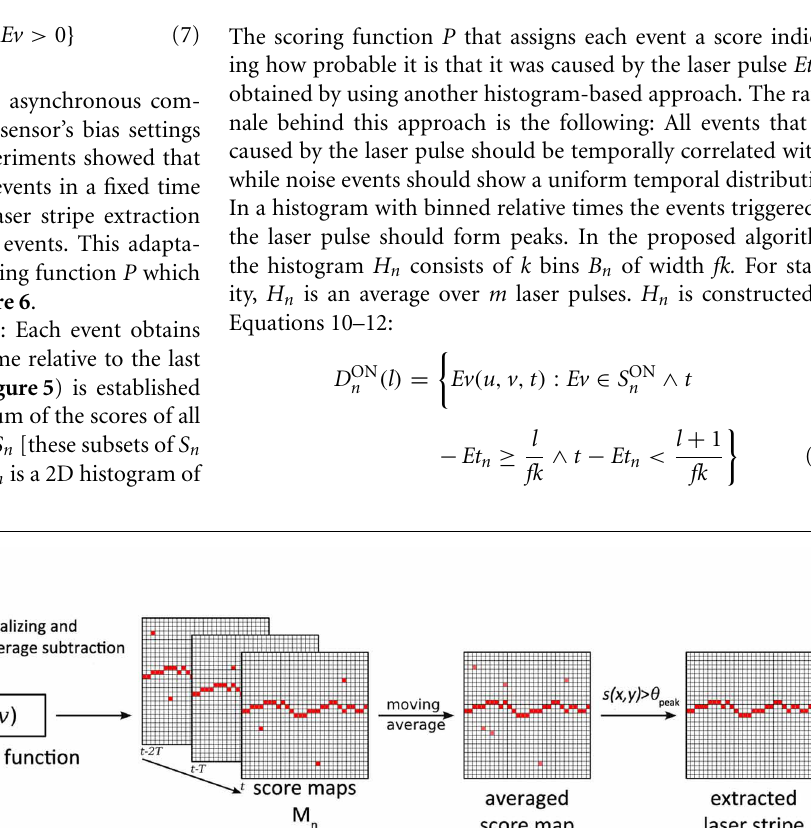
FIGURE 5 | Schematic overview of the laser stripe extraction filter. At the arrival of each laser pulse the temporal histograms are used to adapt the scoring function P, and each event’s score is calculated and mapped on the